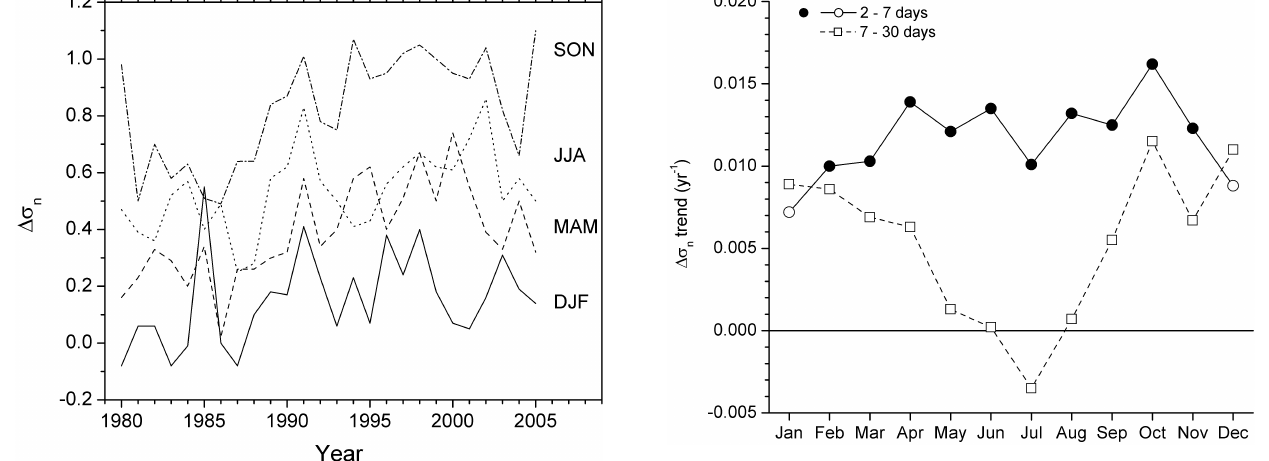
Fig. 10. Time series of 3-monthly mean differences of zonalmerid- ional standard deviations of MLT winds, divided by the magnitudes of the 3-monthly mean prevailing horizontal winds.